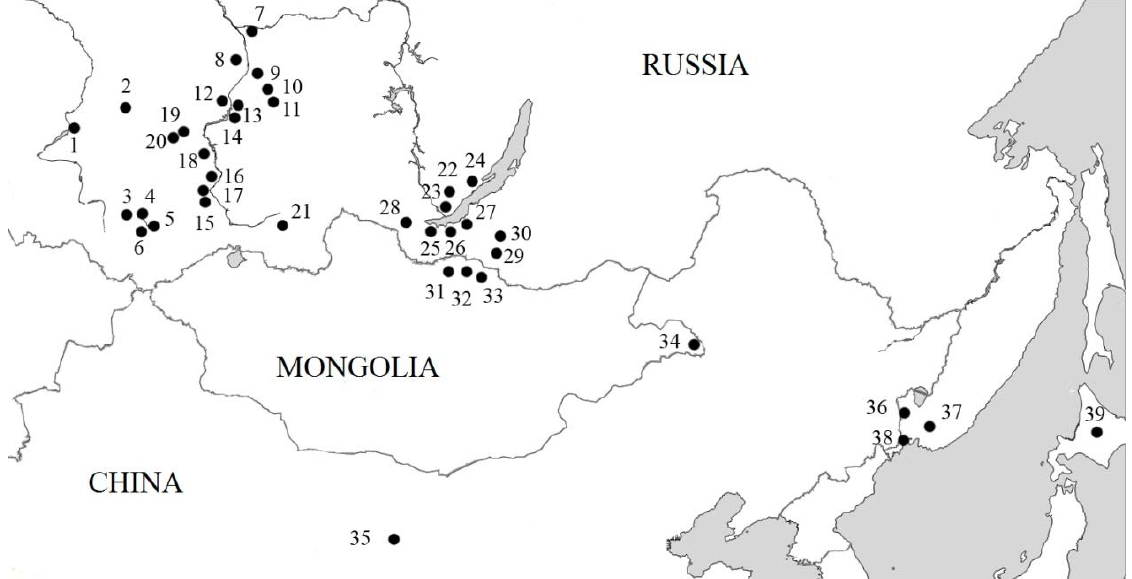
Figure 1. Geographical distribution of A. peninsulae and collection numbers. Arabic numbers beside points are location numbers shown in Table 1.